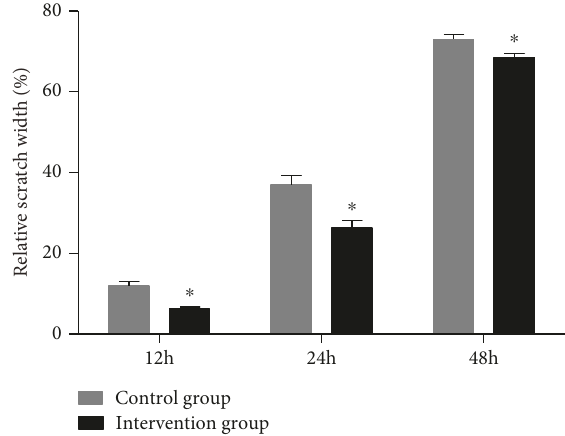
Figure 3: Scratch adhesion test at 12 h, 24 h, and 48 h was conducted. All experiments were triplicated. Data were presented as mean ± SD . ∗ p < 0 05 , compared with the control